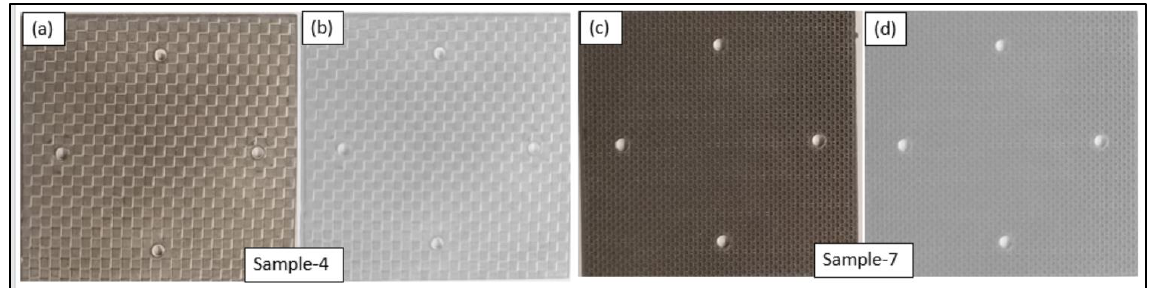
Figure 7: Change of color of the surfaces after applying the hydrophobic spray. Sample-4 (a) before, (b) after, and Sample-7 (c) before, (d)